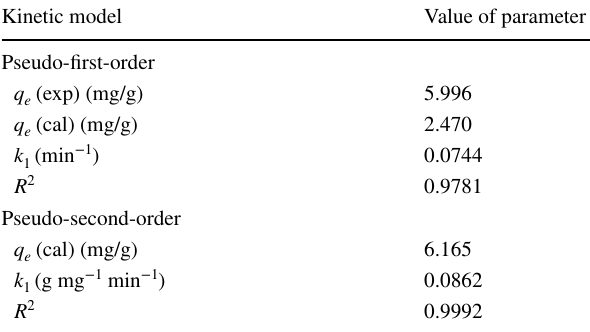
Fig. 7 Pseudo-first-order and pseudo-second-order kinetics for adsorption of Cr(VI) on LLAC [initial Cr(VI) concentration: 71.49 mg/L, pH: 4.22, adsorbent dosage: 0.57, temperature: 26.2 °C and contact time: 60 min] Table 8 Kinetic model parameters and correlation coefficient obtained for adsorption of Cr(VI) on LLAC under optimum conditions Kinetic